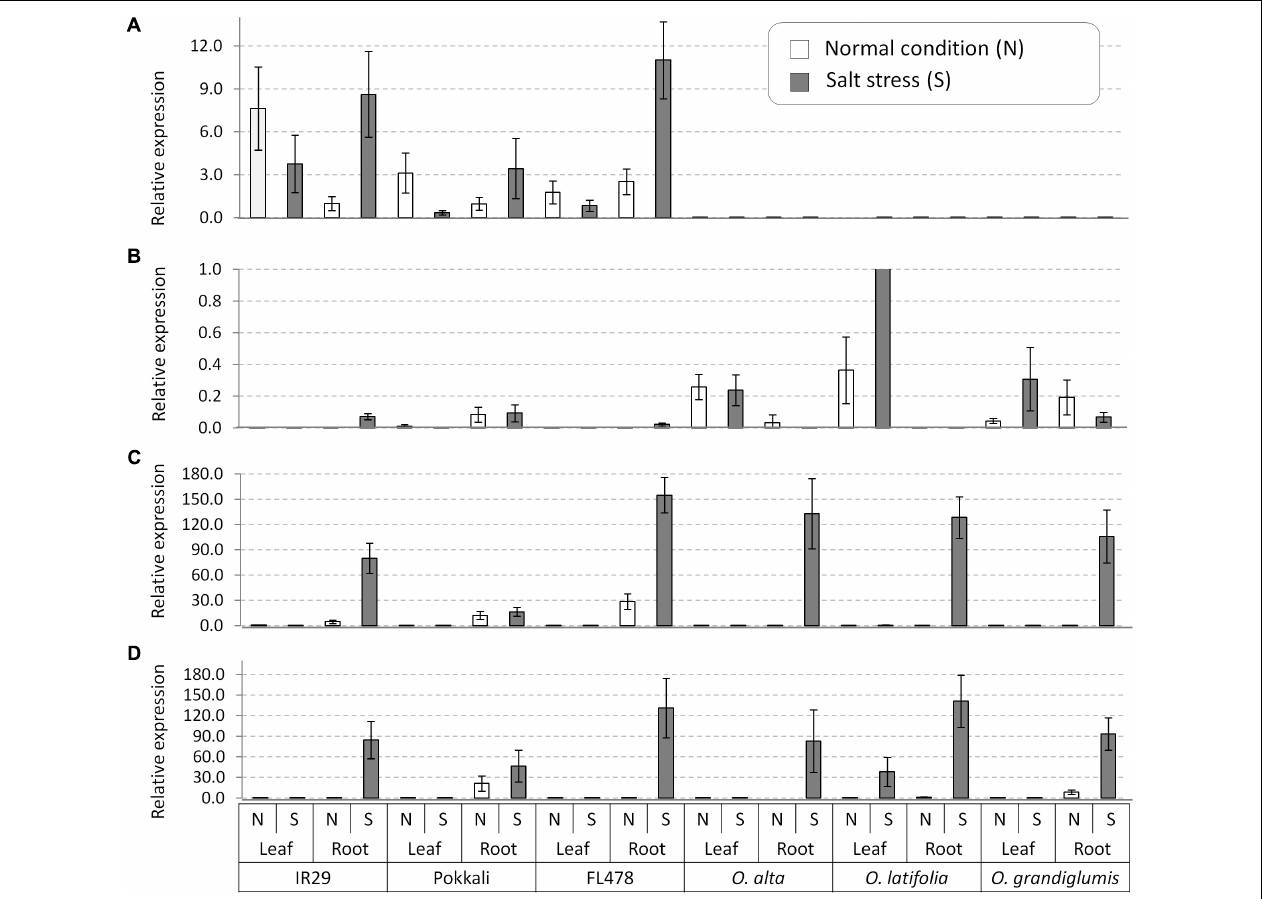
FIGURE 5 | Gene expression analyses of the salt tolerance genes in leaf and root tissues collected from the salt tolerant wild species having the CCDD genomes and the checks varieties. (A) OsNHX1 , (B) OsHKT1;4 , (C) OsHKT1;5 , and (D) OsSOS1 . OsActil1 was used as an internal control of qRT-PCR. N, normal nutrition solution (white bar); S, salt stress (gray bar). Error bar means SD ( n =